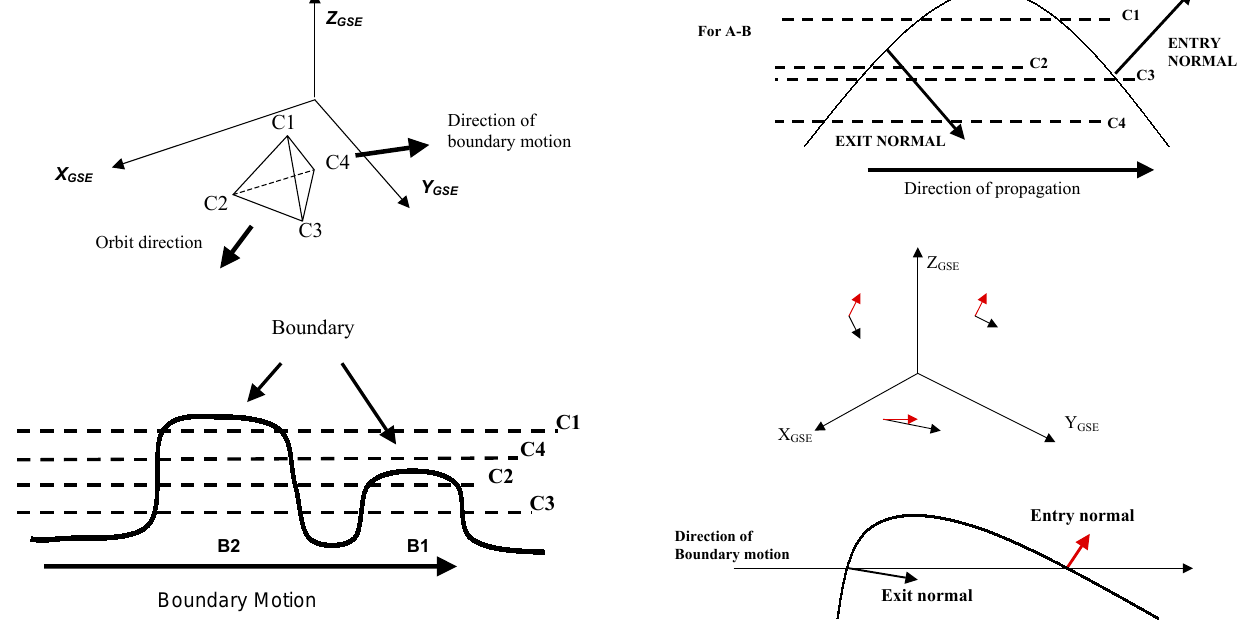
Fig. 14. (a) Illustration of the boundary normal directions for entry and exit of the structure by Cluster, inferring that a wave-or-bulge like feature is passing over the spacecraft. (b) Projection in the GSE plane ( X − Y , Z − Y , Z − X ) of the boundary normal directions of the entry (red) and exit (black) of event A. We note that the arrows also indicate the velocity magnitude, such that the entry velocity (red) ∼ 10km/s, was smaller than exit (black) ∼ 40km/s. (c) This difference in velocities can be described by the waveform shown here, with a shallow leading edge and steep trailing